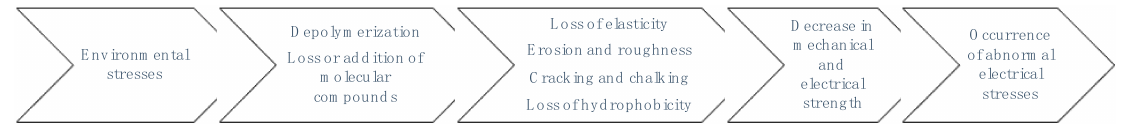
Table 4. Pollution severity based on the equivalent salt deposition density (ESDD) [38].